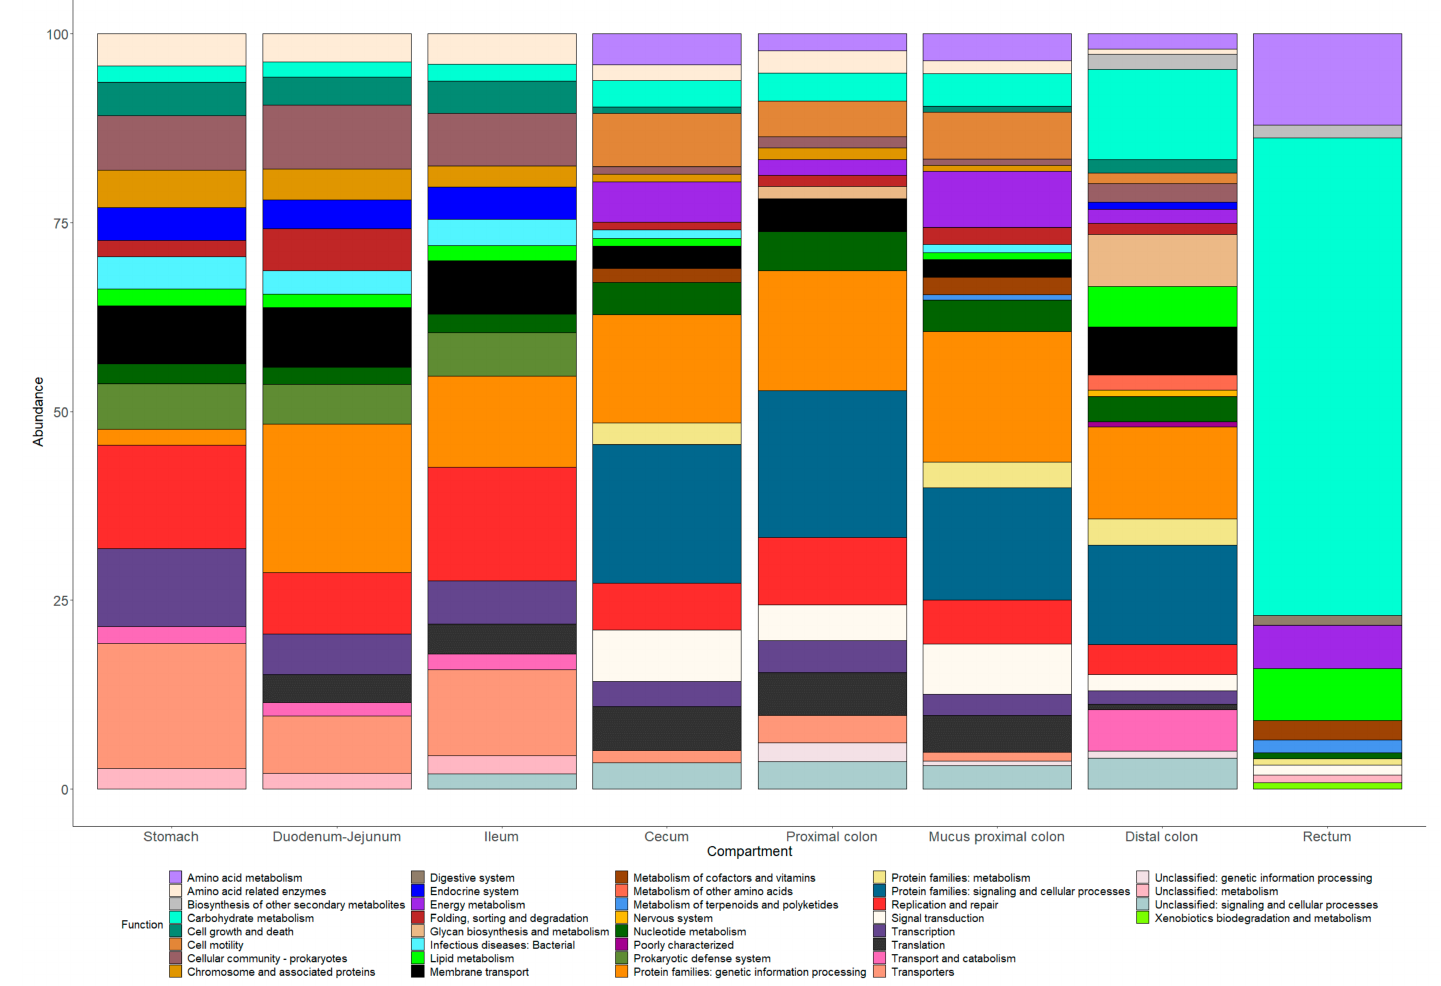
Figure 9. Prediction of functional capacity of the bacterial communities along the GIT of weaning